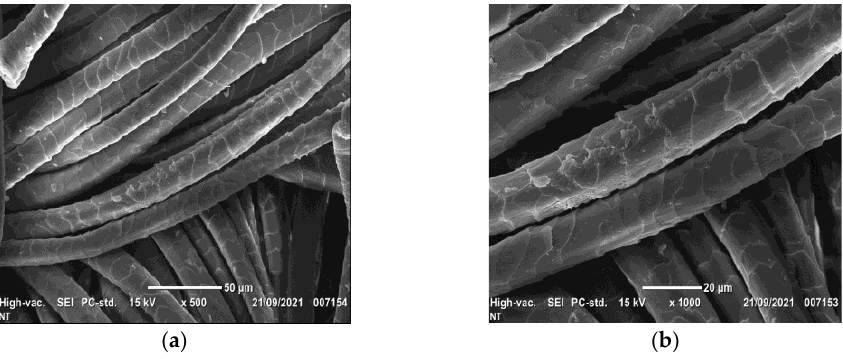
Figure 5. SEM images of the non-treated fabric used for this study ( a , b ). Table 2. Area shrinkage